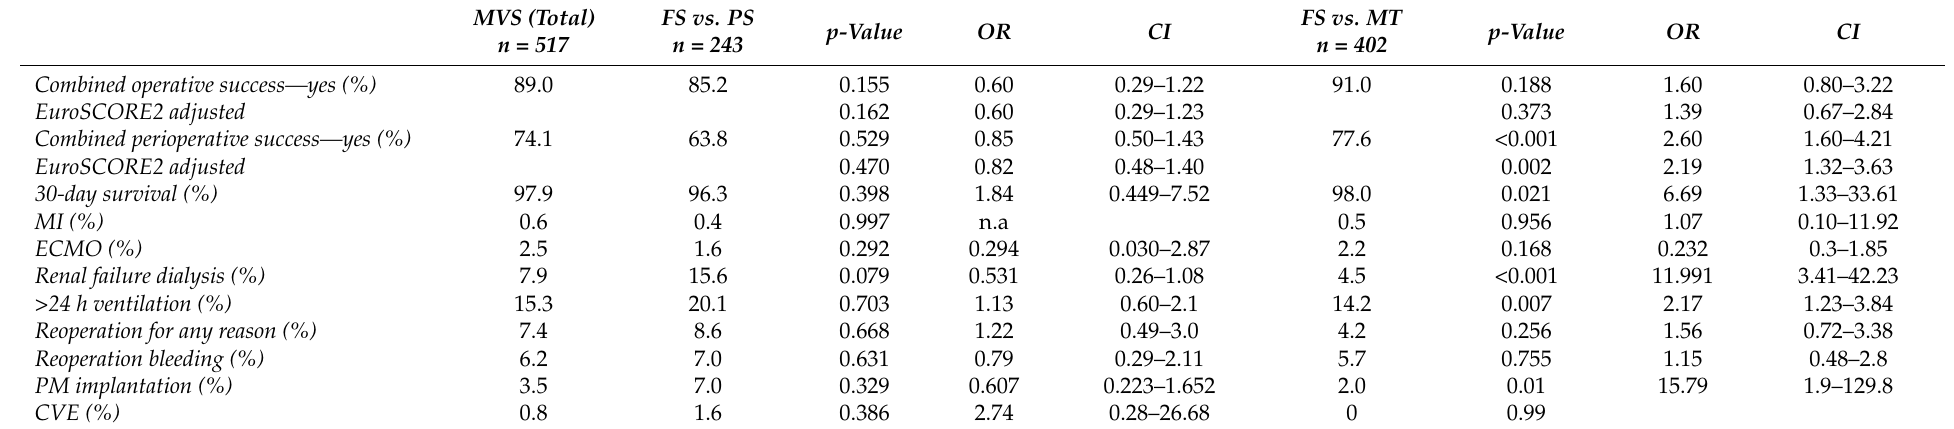
Table 5. Operative and perioperative (30-day) success, according to access type